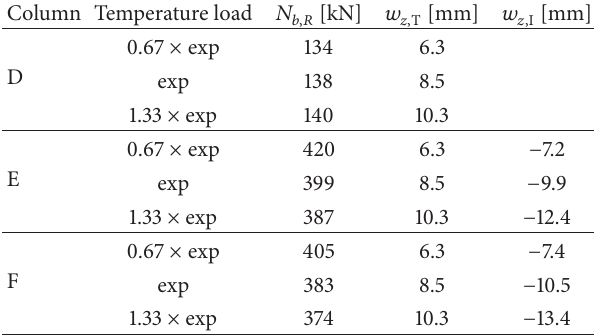
Table 1: Results of parametric study: load resistance 𝑁 𝑏,𝑅 ,